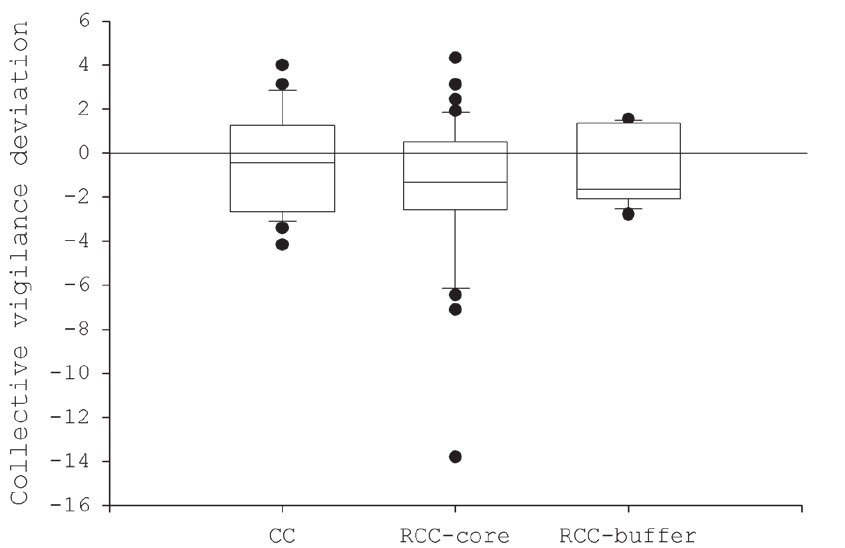
Figure 3. Comparisons of observed and expected collective vigilance between adults and juveniles in two crane species. Collective vigilance was calculated using one adult and one juvenile in each flock. A positive value indicates coordinated vigilance while a negative value indicates synchronised vigilance (CC: common crane; RCC-core: red-crowned crane in the core zone; RCC-buffer: red-crowned crane in the buffer